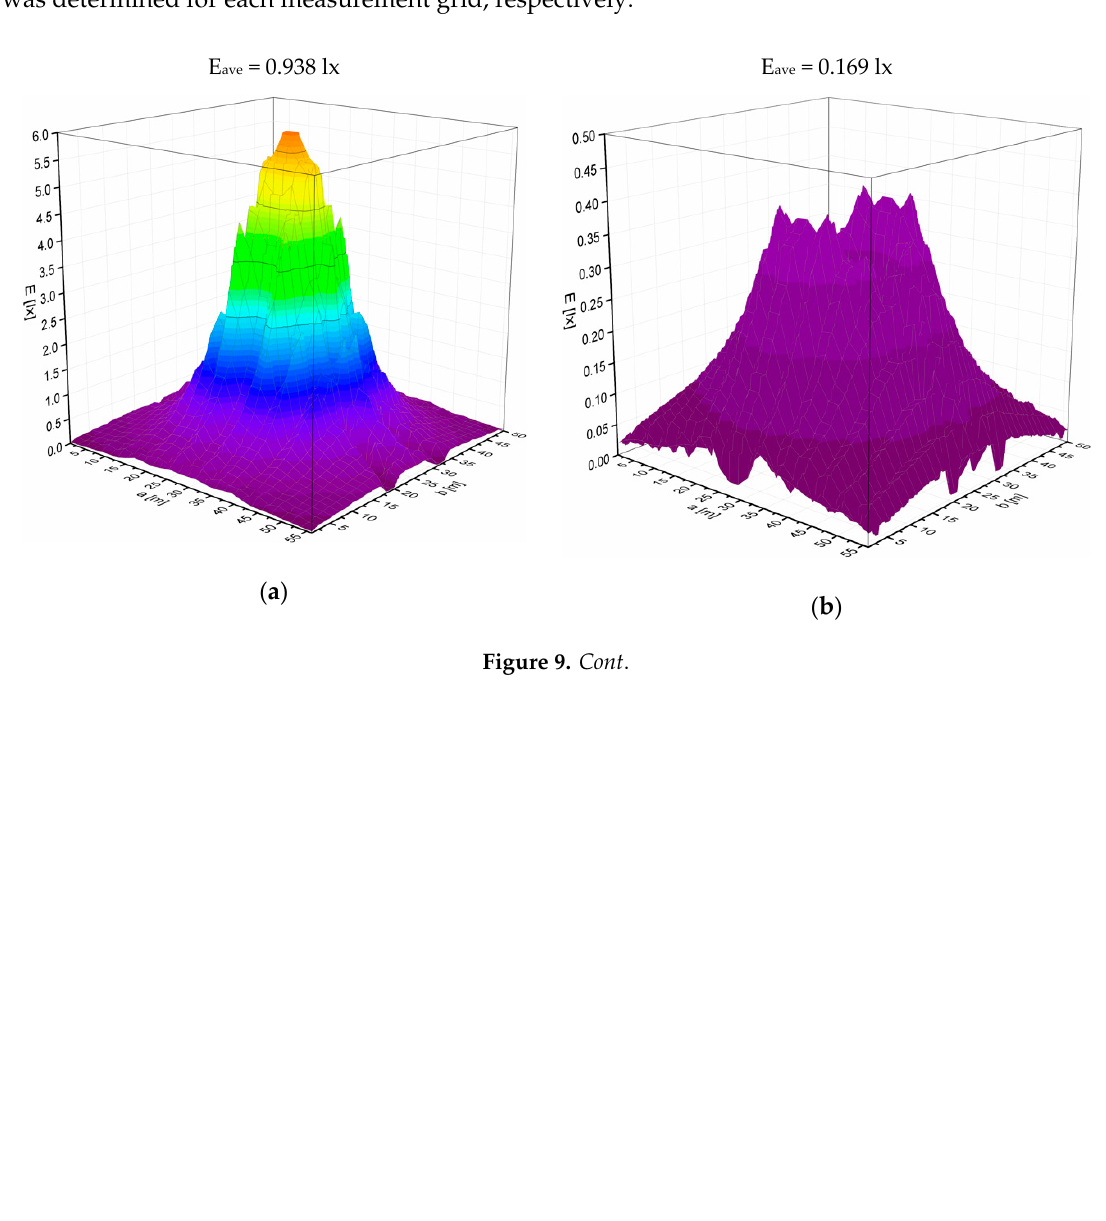
Figure 9. Visualization of the illuminance distribution when using: ( a , c ) oval ball, ( b , d ) oval ball half- covered with black paint, recorded values relate to measurements taken: ( a , b ) from the air using a UAV, ( c , d ) on the ground. Having the average values of illuminances (Figure 9) and knowing the surface of the measuring grid (S = a × b), one can calculate the luminous flux that will be emitted towards the sky and the ground by individual luminaires respectively. It is worth to point out that the luminous flux emitted in the upper hemisphere (wasted luminous flux) is the sum of two components: the direct component (the luminous flux emitted directly into the upper hemisphere by the luminaire) and the intermediate component (the luminous flux reflected from the ground). The illuminance meter installed on the UAV records both illumination caused by radiation emitted directly by the luminaire and radiation reflected from the ground. The luminous flux emitted in the lower hemisphere (useful flux) is mainly the effect of radiation emitted by the installed luminaire. In the case of city centers, artificial radiation